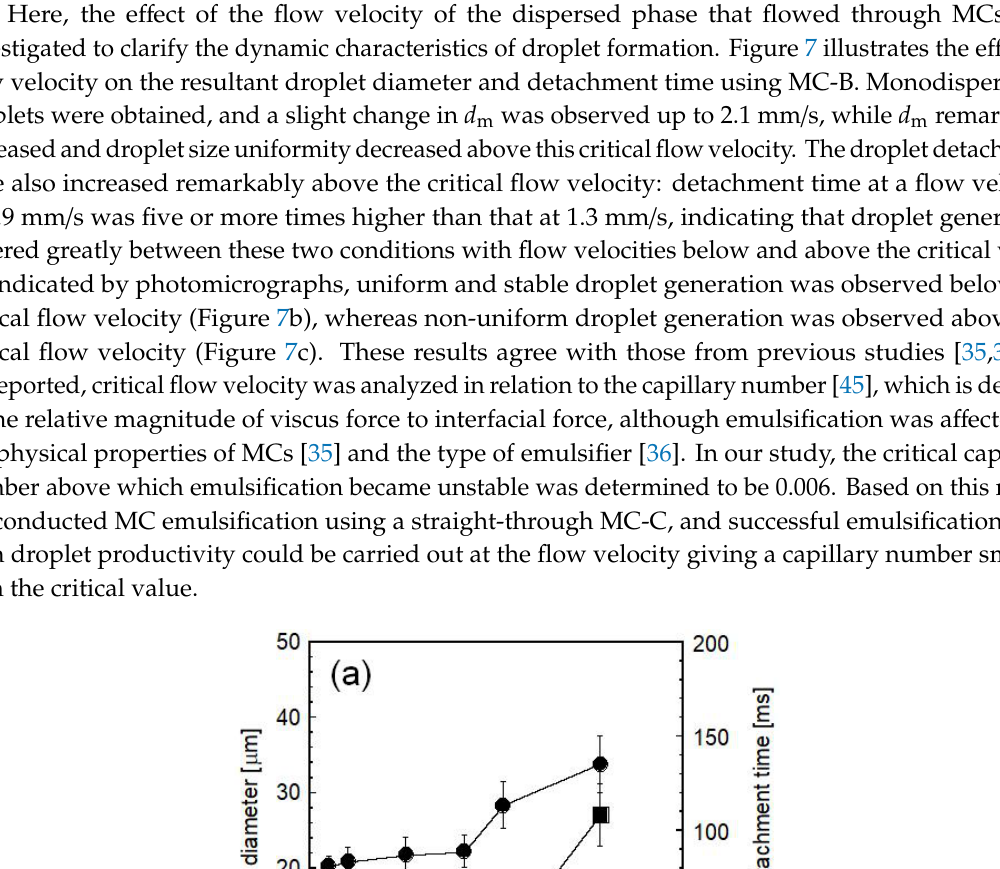
Figure 7. ( a ) Variation of mean diameter ( d m , circles) and droplet detachment time (squares) as a function of the flow velocity of the dispersed phase that flows in a channel, and typical optical photomicrographs of droplets generated from channels ( b ) below the critical flow velocity (1.3 mm/s) and ( c ) above the critical flow velocity (3.9 mm/s). MC-B was used. SC concentration was 3 wt%, and emulsification temperature was 60 °C. The scale bars in ( b ) and ( c ) are 50 µm. 2.2. Preparation of W/O/W Emulsions Containing Palm Oil As the next step, we prepared a water-in-oil-in-water (W/O/W) multiple emulsion encapsulating fine water droplets containing a hydrophilic compound inside palm oil droplets. We conducted two- step emulsification using an ultrasonic homogenizer for primary W/O emulsification and an MC array device with MC-A for secondary (multiple) emulsification. Here, 0.2 M NaCl was added to both internal and external water phases to equilibrate the osmotic pressure between both phases. The primary emulsification for preparing W/O emulsion was carried out using a 0.2 M NaCl aqueous solution containing 0.4 mM calcein as the dispersed phase and melted palm oil containing 3 wt% polyglycerin polycondensed ricinoleic acid ester (PGPR) as the continuous phase. The typical W/O emulsion presented in Figure 8a,b had a d m of 1.36 µm with a polydispersity index of 0.21 determined by DLS measurement. Figure 8c,d presents the results of the preparation of W/O/W emulsions by MC emulsification using MC-C. The primary W/O emulsion was used as the dispersed phase, and 0.2 M NaCl aqueous solutions containing 0.5 or 3 wt% SC were used as the continuous phase. At 0.5 wt% SC concentration, multiple droplets were generated; however, their diameters were not uniform. In contrast, no droplet was obtained due to the continuous flowing out of the oil phase at the same SC concentration for O/W emulsification (Figure 3b). This difference in emulsification behavior might be attributed to the presence of PGPR in the oil phase of the primary W/O emulsion stabilizing the oil-water interface. At 3 wt% SC concentration, monodisperse multiple droplets with a d m of 43.2 µm and a CV of 8.3% could be obtained (Figure 8d,e). Under a fluorescent microscope, the multiple droplets recovered from the emulsification module emitted green fluorescence derived from calcein dissolved in the internal water droplets (Figure 8f,g). The entrapment yield of calcein in the multiple droplets stabilized by 3 wt% SC was determined to be 85.0% with 3.17% as the standard deviation just after preparation. This high entrapment efficiency was attributed to low-shear, non-